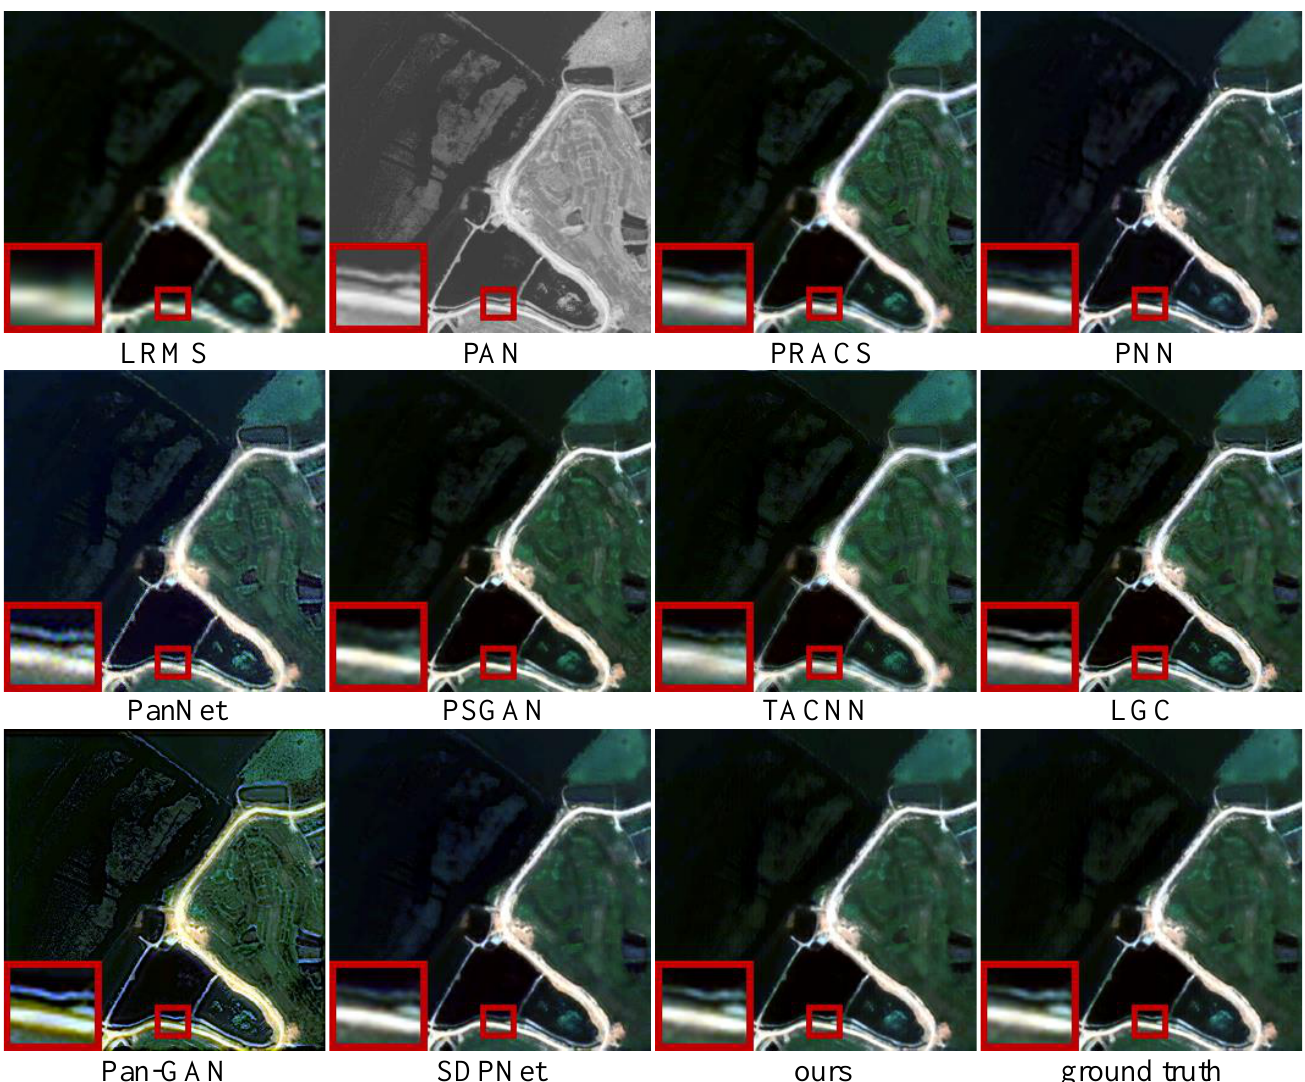
Figure 8. Qualitative comparison of CPNet with other eight pan-sharpening methods on the data from the QuickBird data